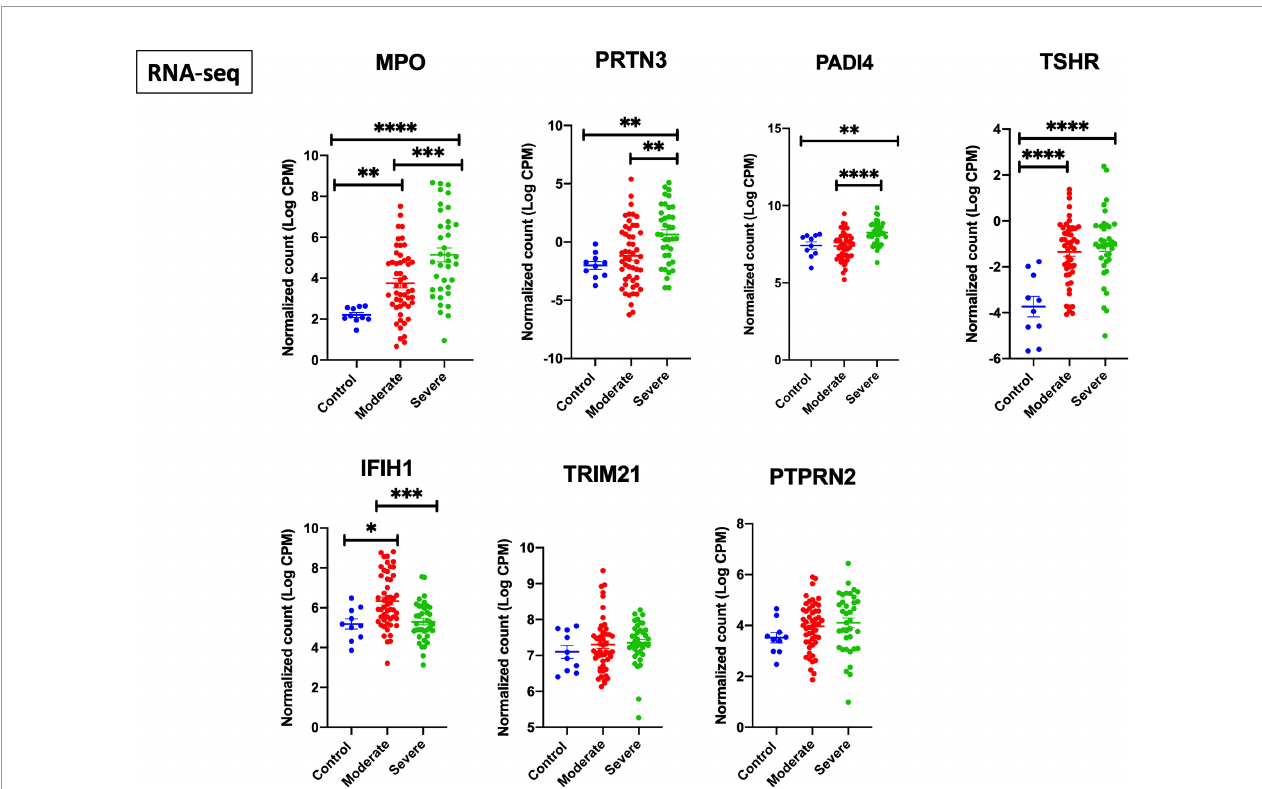
FIGURE 2 | Upregulation of MPO, PRTN3, PADI4, and TSHR mRNA levels in leukocytes of severe COVID-19 patients. The COVID-19 leukocyte data set (GSE157103) analyzed included n = 10 controls, n = 51 moderate COVID-19, and n = 49 severe COVID-19 (12 non-critical and 37 critical). An increase in gene expression of MPO, PRTN3, PADI4, and TSHR in severe COVID-19 compared to moderate and healthy controls. IFIH1 was increased in moderate but not severe COVID-19. Unpaired student t-test was used to compare between the independent groups (mRNA normalized expression between different groups). ∗ p < 0.05, ∗∗ p < 0.01, ∗∗∗ p < 0.001, ∗∗∗∗ p < 0.0001. Results are presented as mean (± SEM) of mRNA